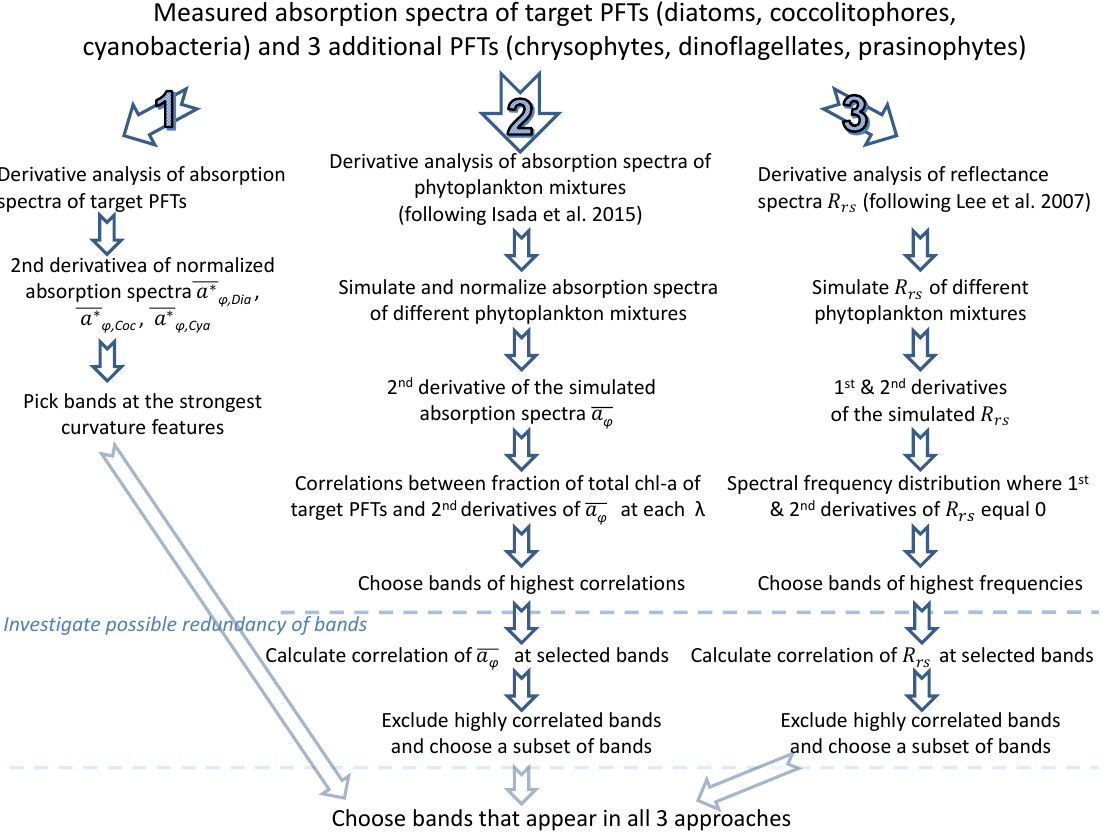
Figure 1. Flowchart showing the three different approaches to select bands for phytoplankton functional type (PFT) retrievals and the fourth selection method based on all three